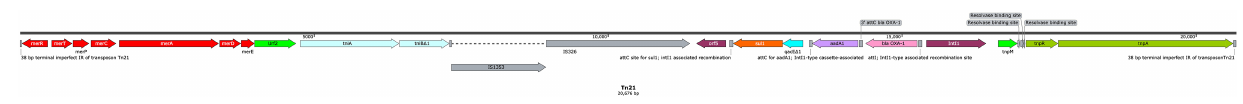
FIGURE 2 | Genetic map of Tn 21 present in both pMG101-A and pMG101-B – the backbone consisting of the mer operon (red) and transposase genes (green). The insertion of the Tn 402 -like element containing Class I integron with cassette array encoding the following resistance genes: bla OXA-1 , aadA1 , qacE ∆ 1 , and sul1 . The Tn 21 mobile genetic element is flanked by two 38 bp imperfect inverted